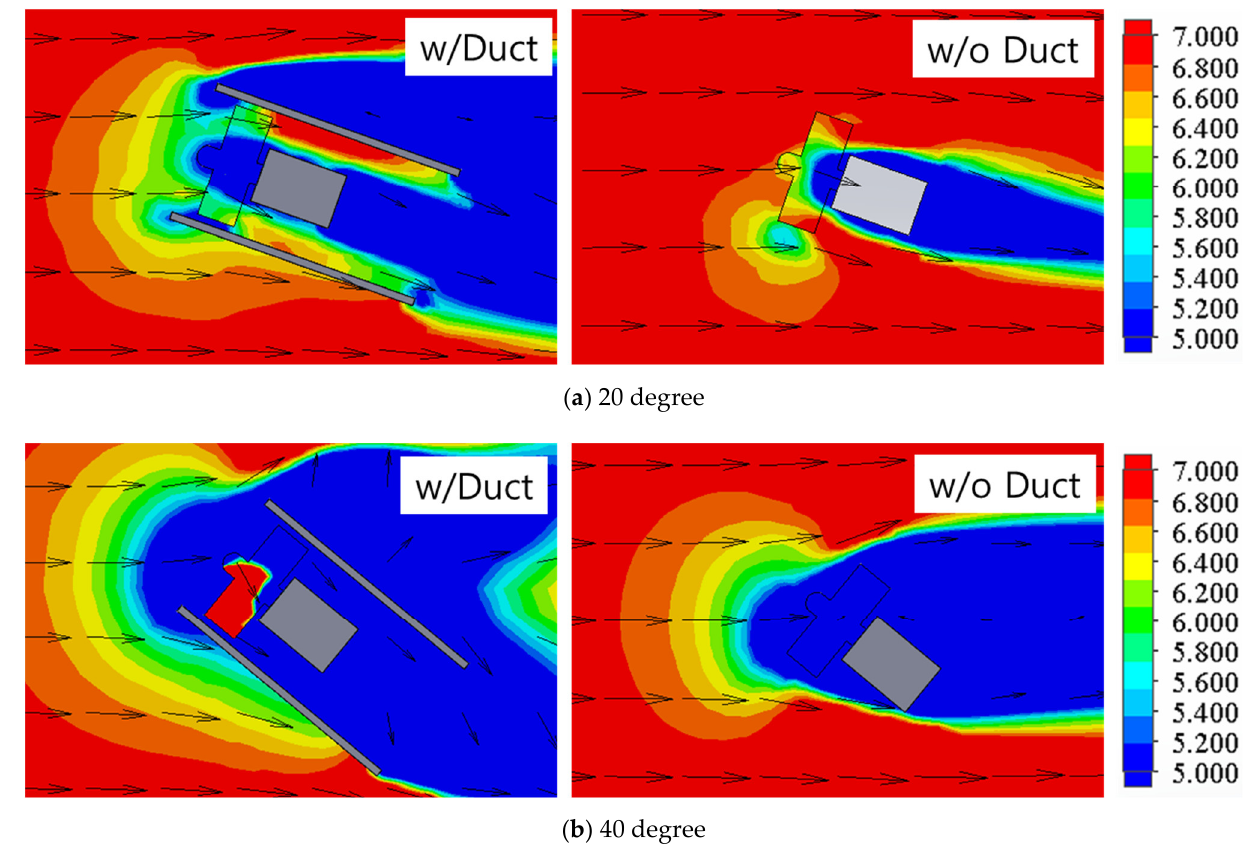
Figure 3. Comparison of wind speed (m/s) for wind direction change.